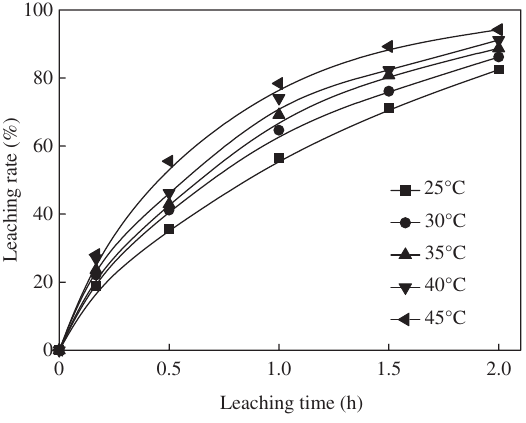
Figure 4: Effect of temperature on silver leaching efficiency.